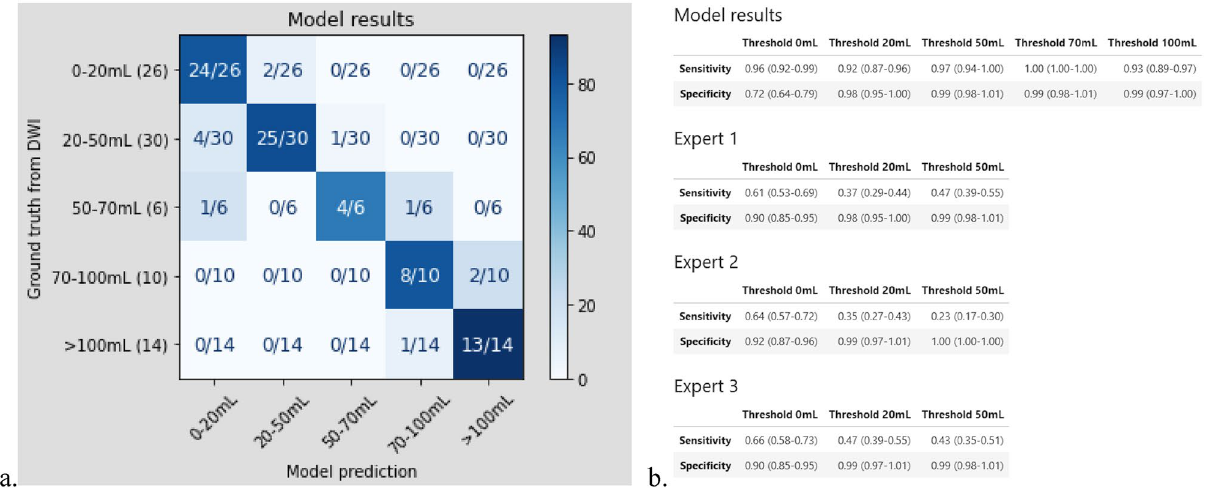
Figure 2. Detailed confusion matrix for additional volume stratification (as per Fig. 1d), at the 50–70 mL, 70–100 mL, and > 100 mL ranges, in the “MCA-territory only” test set ( a , calculated at the model’s 0 mL-threshold for infarct detection). ( b ) Comparison of model sensitivity, specificity at the 20 mL, 50 mL, 70 mL, and 100 mL thresholds, versus the three individual expert raters at the 20 mL and 50 mL